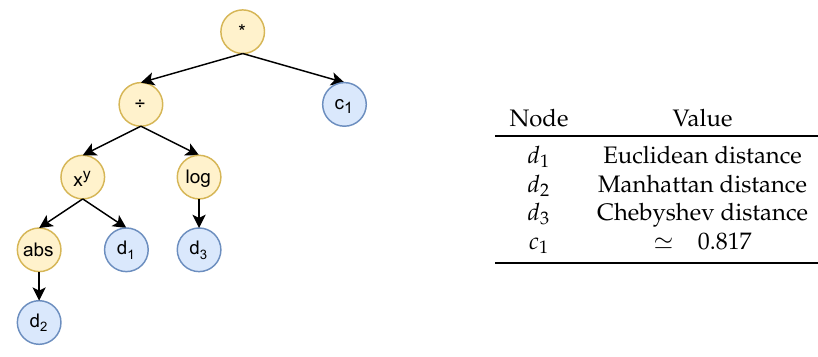
Figure 8. The computation tree generated by the genetic programming algorithm.